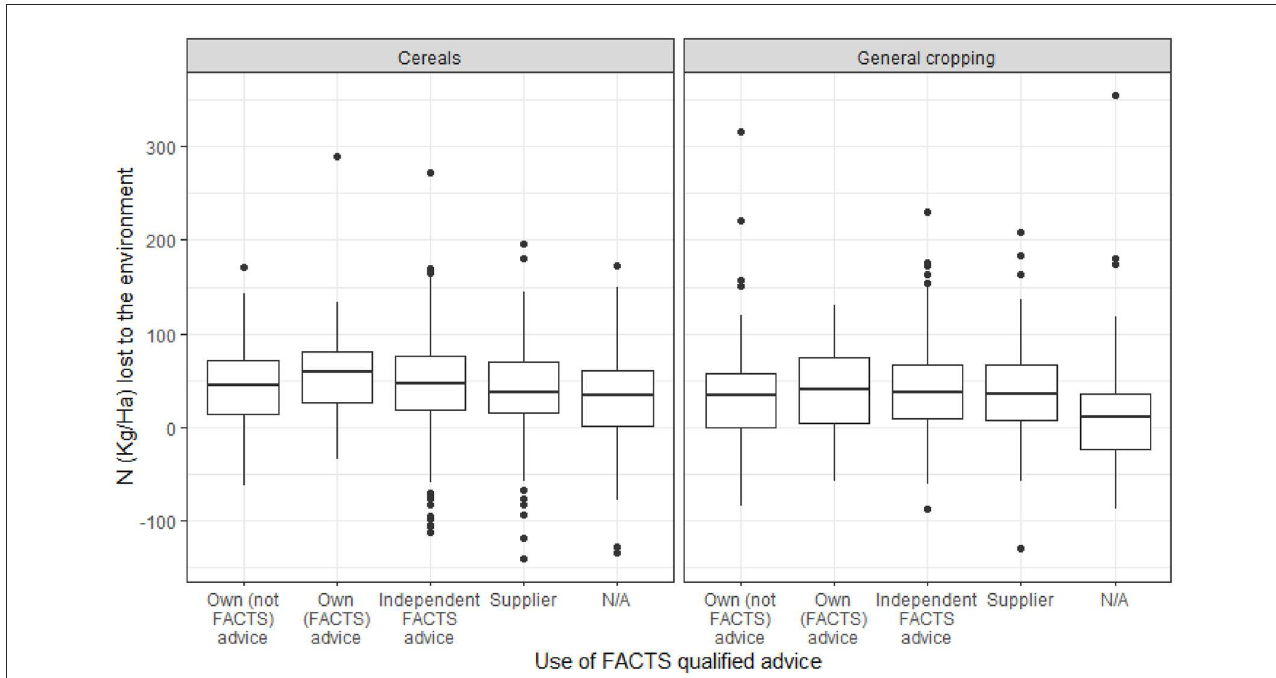
FIGURE3 Box plots of N balance against the use of FACTS qualified advice, for Cereal and General Cropping farms. Scores of N/A are assigned for pre 2016 when FACTS data were not available.